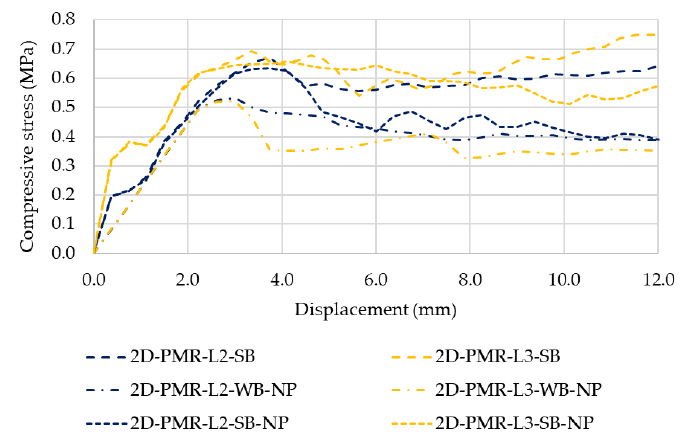
Figure 18. Stress–displacement diagrams for the 2D-PMR L2 and L3 models: strong and weak bond assumptions without lateral plates and a strong bond with lateral plates.